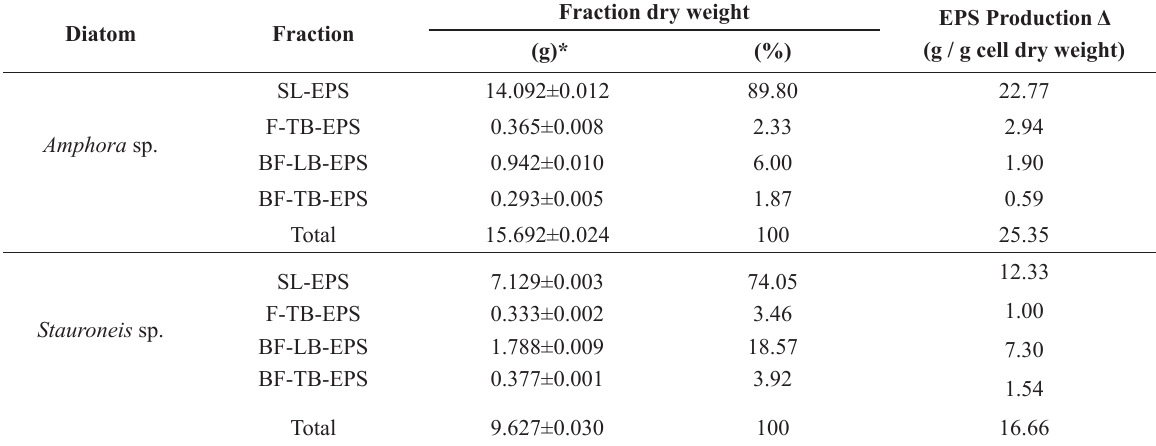
Distribution and production of EPS from the diatoms Amphora sp. and Stauroneis sp.